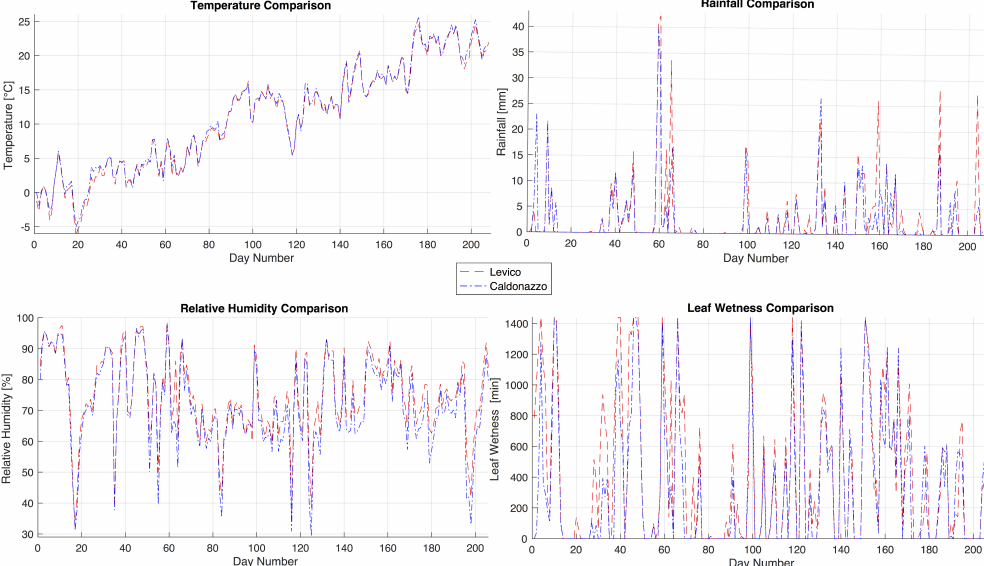
Figure 5. Comparison between main weather data of Caldonazzo and Levico weather stations, from the 1 January 2016 to 26 July 2016. The red dashed line represents Levico’s weather data, and the blue line represents Caldonazzo’s weather data. Note that these two stations are only 4.6 km apart.